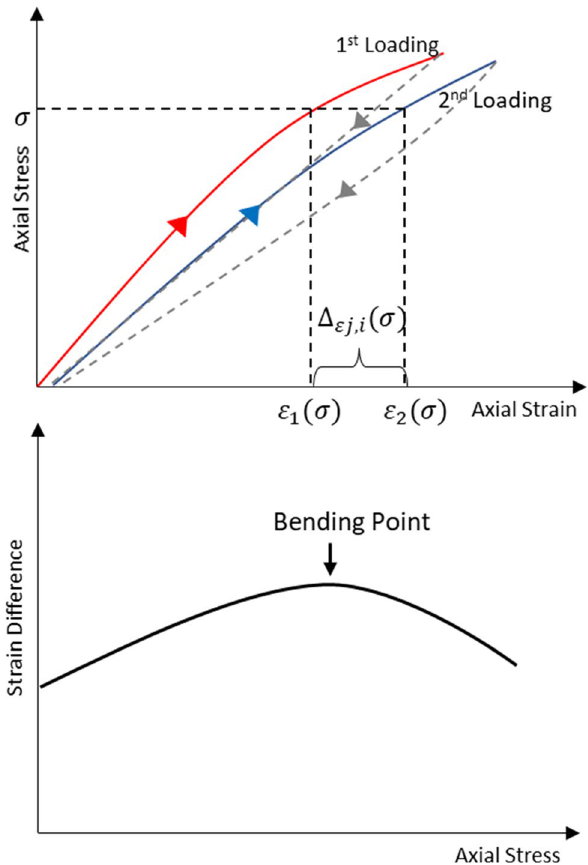
Fig. 5 Schematic of the DRA showing the strain difference function and the bending in the curve